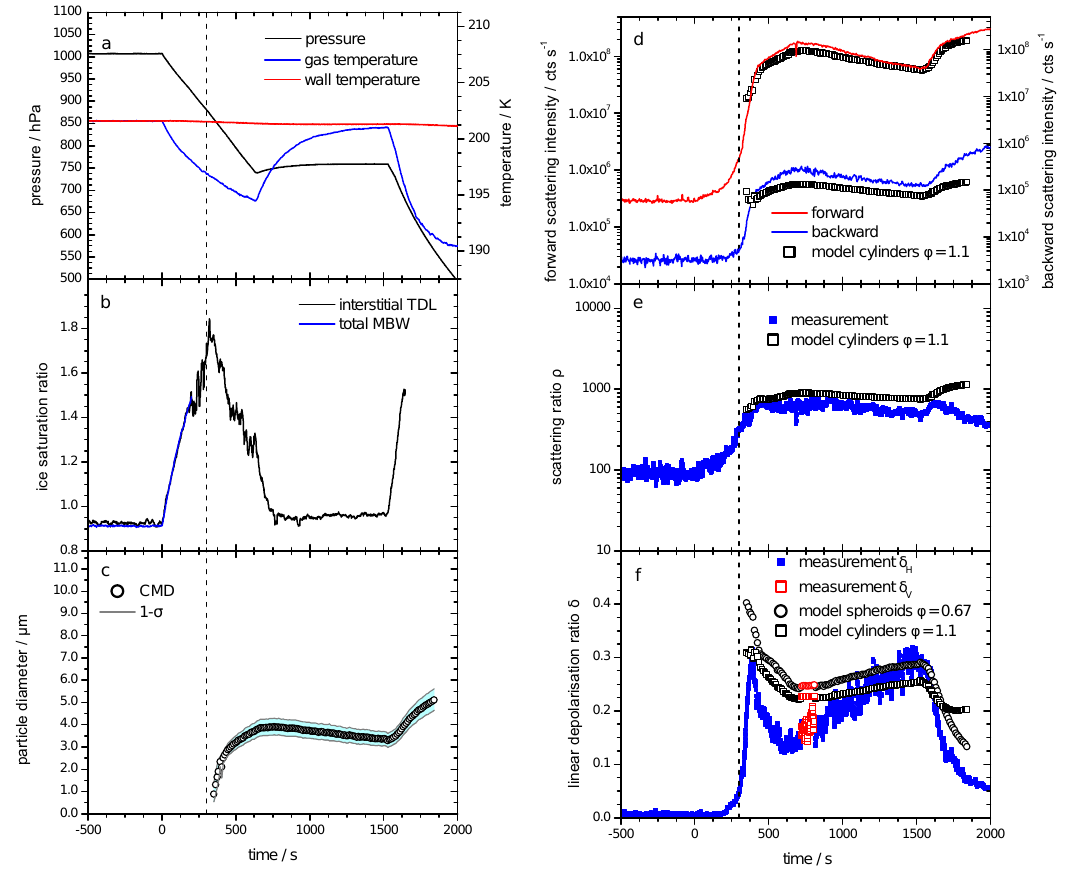
Fig. 9. Homogeneous ice nucleation experiment ICE01 14. The individual panels show the same measurements as in Fig. 6, with the exception of (b) that shows the evolution of the humidity as ice saturation ratio instead of relative humidity. The onset time of ice nucleation is indicated by the dashed vertical lines in the panels. The SIMONE measurement results depicted in (d–f) were modelled by T-matrix calculations for finite cylinders and spheroids. Note that the SID3 instrument was not available for this experiment. See text for